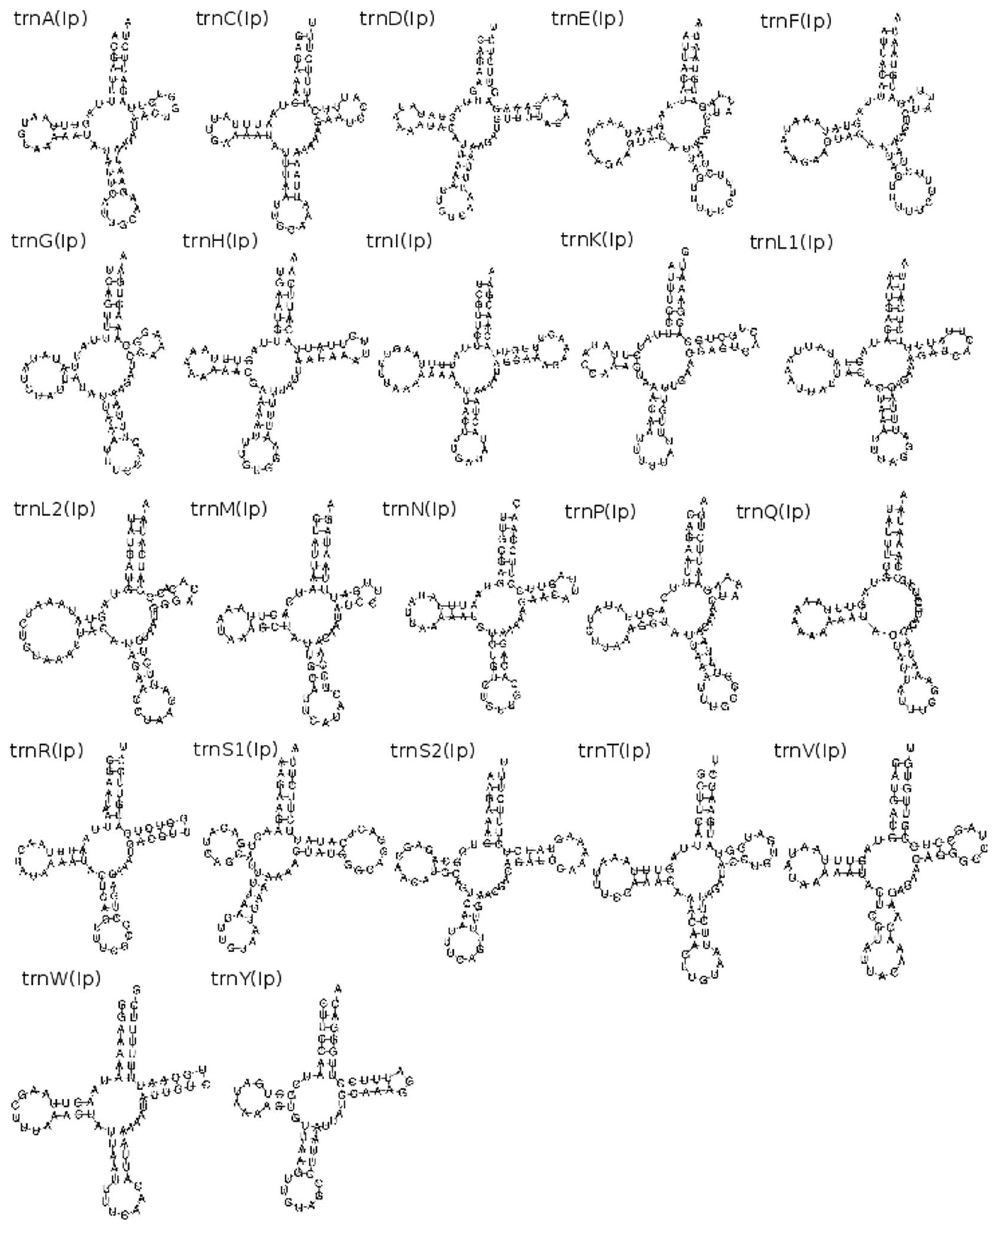
Figure 4. Predicted secondary structure of tRNAs from the mitochondrial genome sequences of and Isodiametra pulchra as predicted by MiTFi in